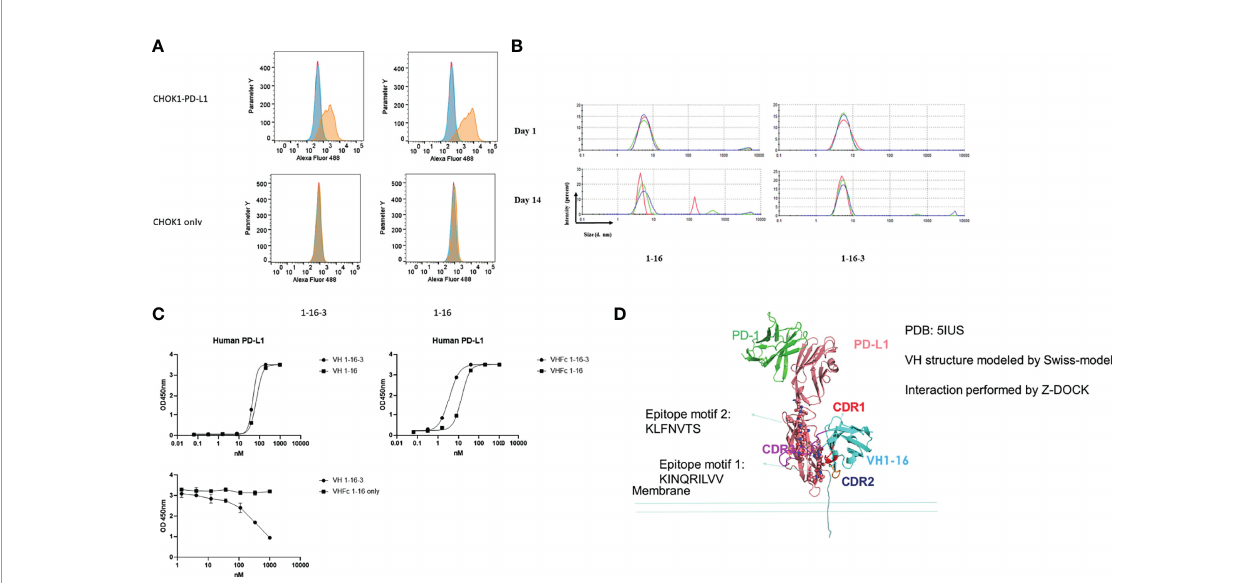
FIGURE 3 | Characterization of VH domains 1-16 and 1-16-3. (A) Flow cytometry analysis for binding of VH 1-16 and 1-16-3 to PD-L1 expressed on the surface of CHOK1 cells; blue peaks represent cells stained with AF488 conjugated secondary antibody only, red peaks represent cells stained with isotype control and then AF488 conjugated secondary antibody, yellow peaks represent cells stained with VH domains and then AF488 conjugated secondary antibody; (B) Dynamic light scattering analysis for evaluation of the aggregation propensity of domain s domains 1-16 and 1-16-3; Curves with different color are different repeats; (C) ELISA of 1-16 and 1-16- 3 against PD-L1 with or without human IgG1 Fc, and their competition; (D) Structural modelling of PD-L1 with VH 1-16. Epitopes were labeled in the fi gure.